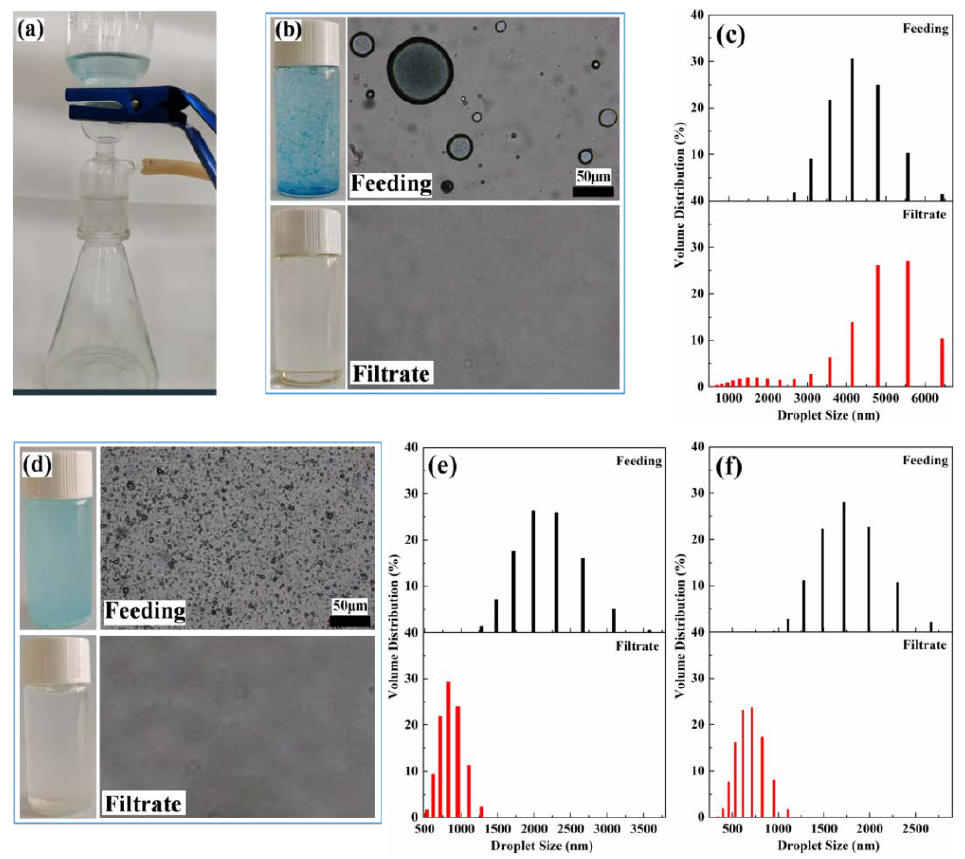
Figure 5. ( a ) Digital photographs of water-in-oil emulsion separation apparatus, and separation results of ( b , c ) emulsion-I, ( d , e ) emulsion-II (1), and ( f ) emulsion-II (2). Table 3. Separation performance of the HSMX membrane to separate water-in-oil emulsions.